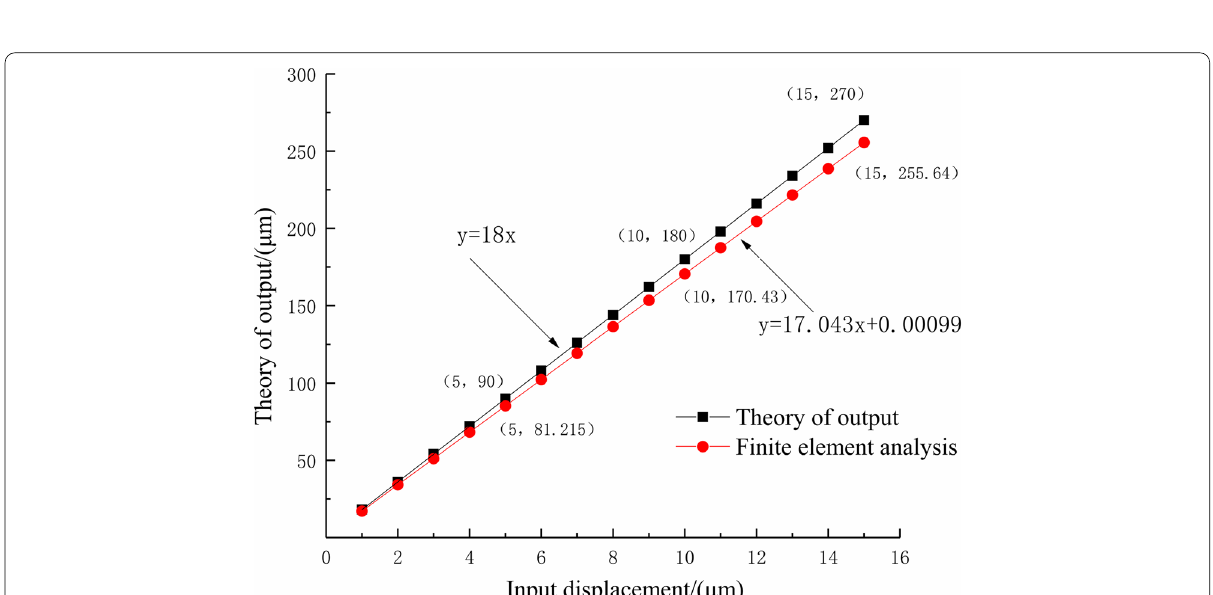
Fig. 9 The linear fitting diagram of theoretical output and finite element